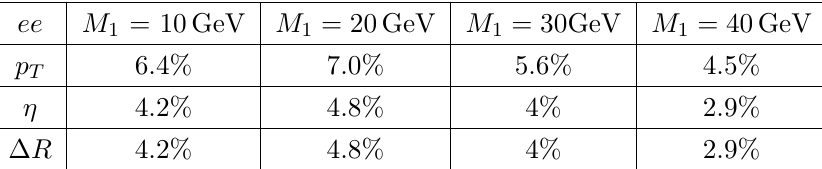
Table 1 . Signal e(cid:14)ciciencies after consecutive cuts on p T , (cid:17) and (cid:1) R for the ee channel in the inner tracker, for various heavy neutrino masses.